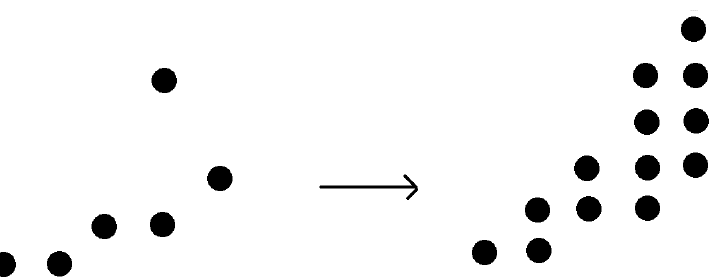
Figure 3. ( left ) An example of an activation diagram. The activation diagram turns into an acti- vation graph. ( right ) A new black vertex appears in a row of the activation graph due to the two corresponding black vertices in the previous row in the activation